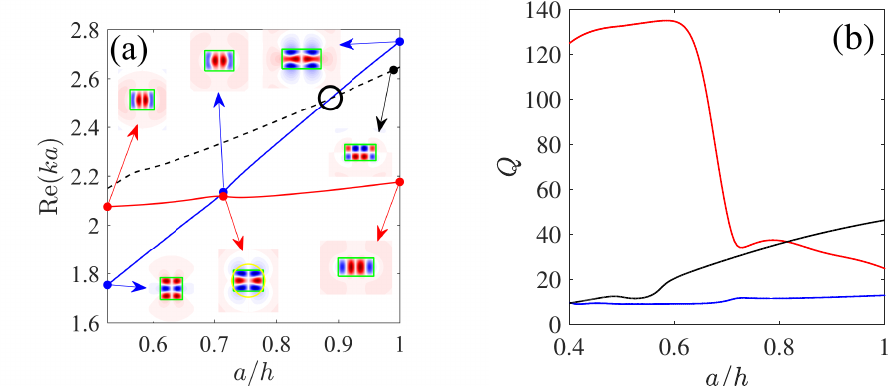
Figure 3. ( a ) Avoided crossing of the TM-resonances in isolated disk. Insets show the profiles of the component of magnetic field H φ . ( b ) The behavior of the Q